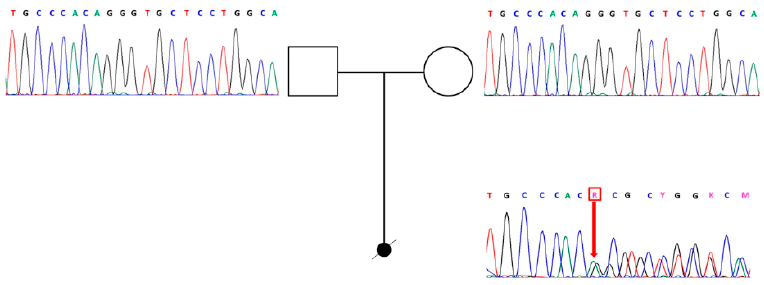
Figure 2. Genealogic tree of the family with Sanger sequencing of exon 21 of